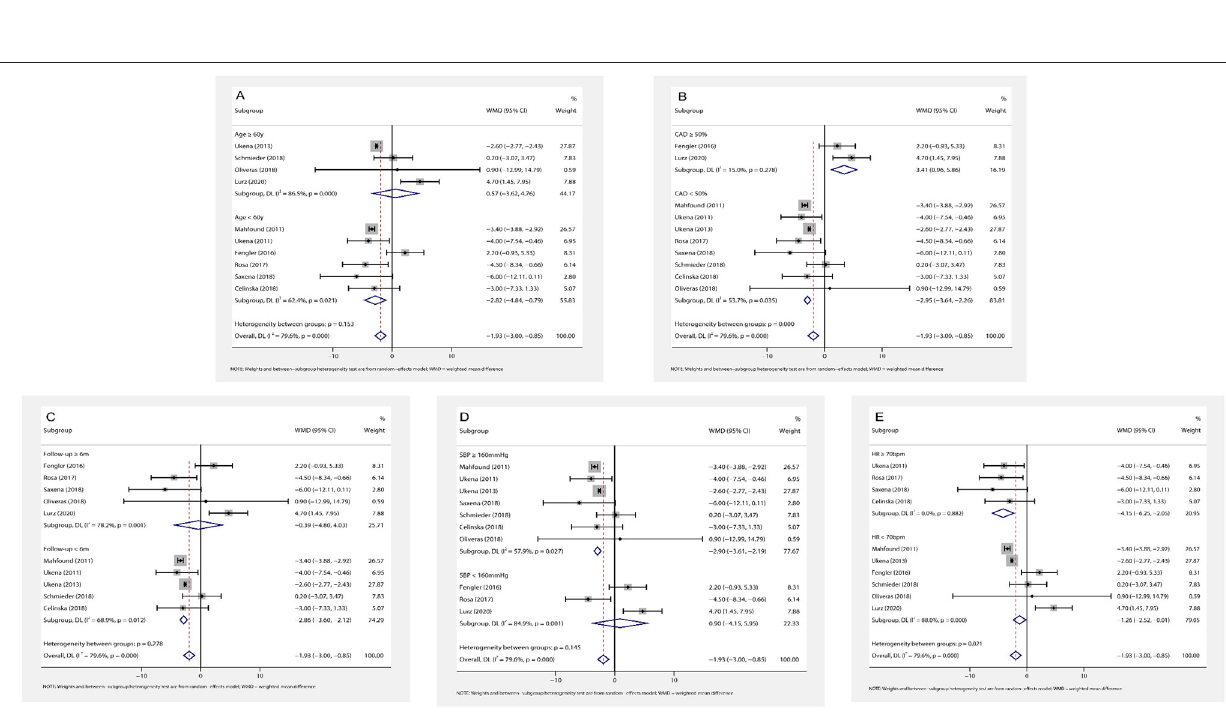
FIGURE 4 | The forest plot of subgroup analysis: (A) by age; (B) by the prevalence of coronary artery disease (CAD); (C) by the length of follow-up; (D) by baseline systolic blood pressure (SBP); (E) by baseline HR. Weights and between subgroup heterogeneity test are from random-effects model. WMD, weighted mean